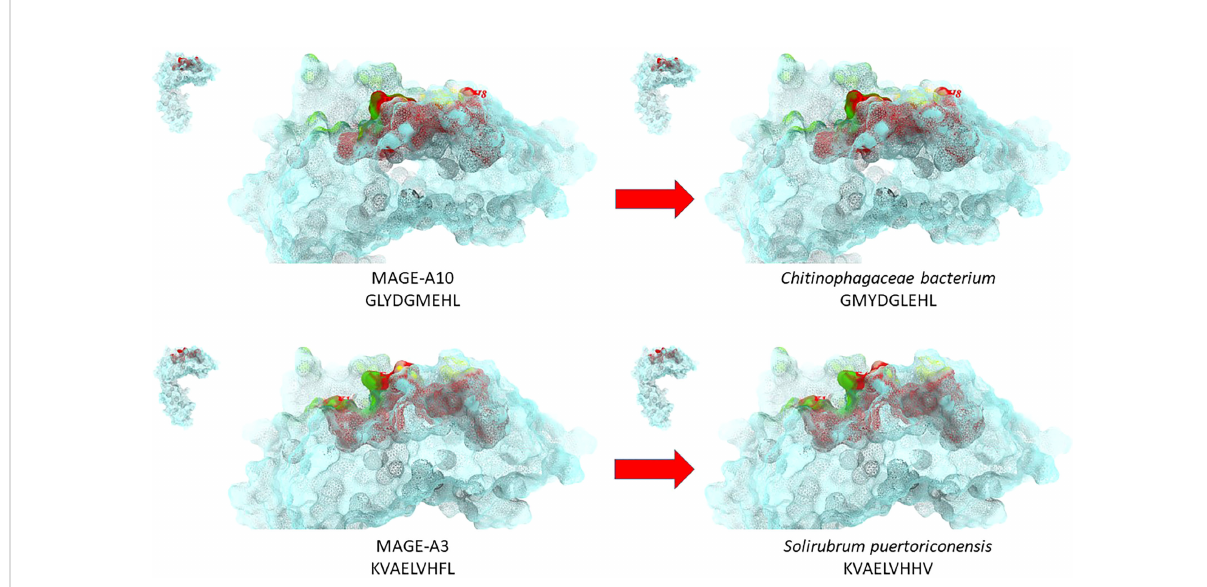
FIGURE 2 Structural predicted conformation of paired TAA and microbiota peptides. The conformation of the paired microbiota and TAA peptides bound to the HLA-A*02:01 molecule is shown. The prediction was performed using as template structure the HTLV-I LLFGYPVYV peptide crystallized with the HLA-A*0201 molecule, the b 2 microglobulin, the a and b chains of the TCR (PDB https://www.rcsb.org/structure/1AO7). Green areas = contact points with the TCR a chain; Yellow areas = contact points with the TCR b